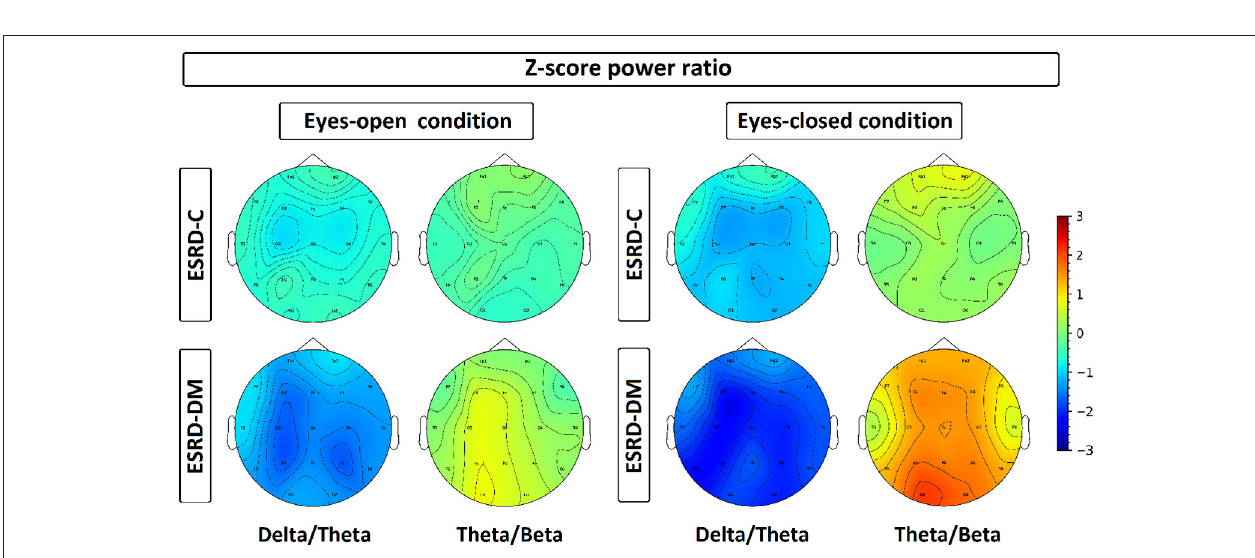
FIGURE 7 | Z-scores of delta/theta and theta/beta ratios have been plotted in a topographical map by representing each channel with its median value, which is represented by color ranged from − 3.00 to 3.00. Delta/theta and theta/beta ratio in ESRD-DM were discovered with consistent deviation from healthy control and ESRD-C, especially in eyes-closed condition. On the contrary, these ratio of ESRD-C were rarely deviated from healthy control, except delta/theta in eyes-closed condition.